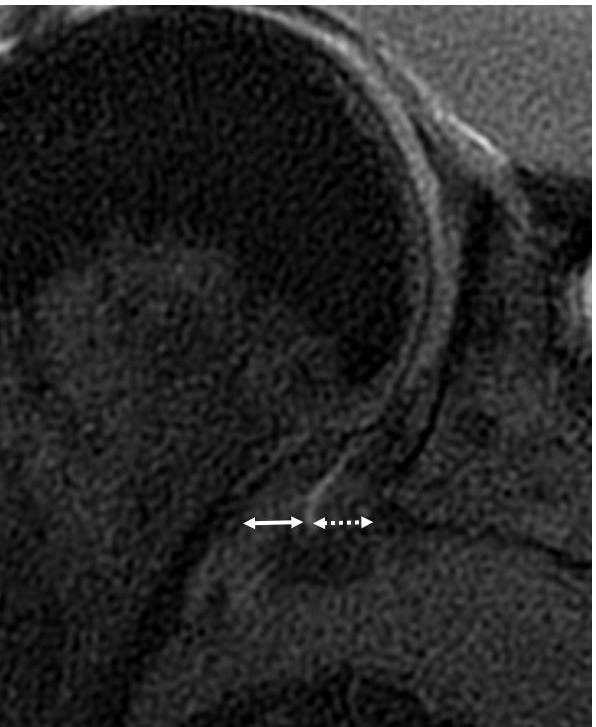
Figure 2. Coronal oblique non-contrast fat-suppressed T2-weighted fast spin-echo MRI of the right shoulder in a 44-year-old woman with adhesive capsulitis shows method used to measure inferior glenohumeral ligament thickness at its glenoidal (dotted double arrow) (4 mm) and humeral insertion (double arrow) (4.5 mm).